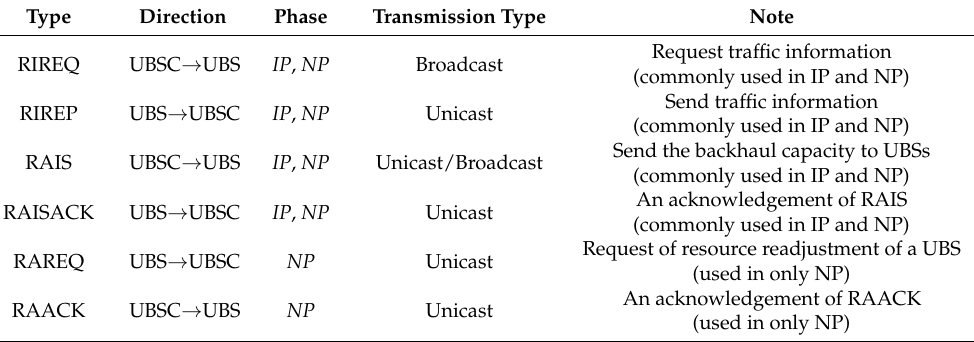
Table 2. Messages of the UBSI resource allocation protocol. RIREQ: Resource Information Request; IP: initialization phase; NP: normal operation phase; RIREP: Resource Information Response; RAIS: Resource Allocation Information Send; RAISACK: Resource Allocation Information Send